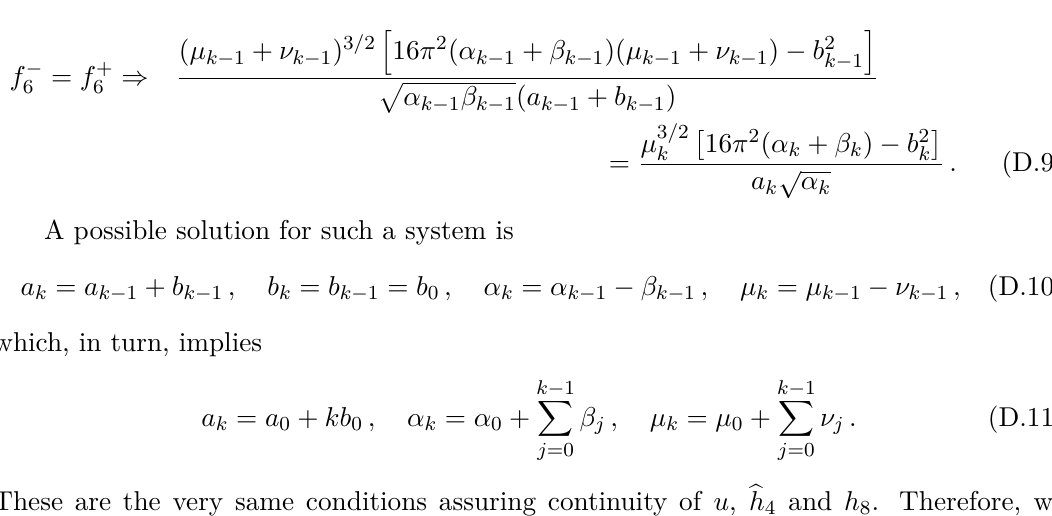
Figure 13 . Behaviour of the solutions at both ends of the ρ -interval for u = constant. We find that the CY is of finite size, while the S 3 diverges at both ends of the 2